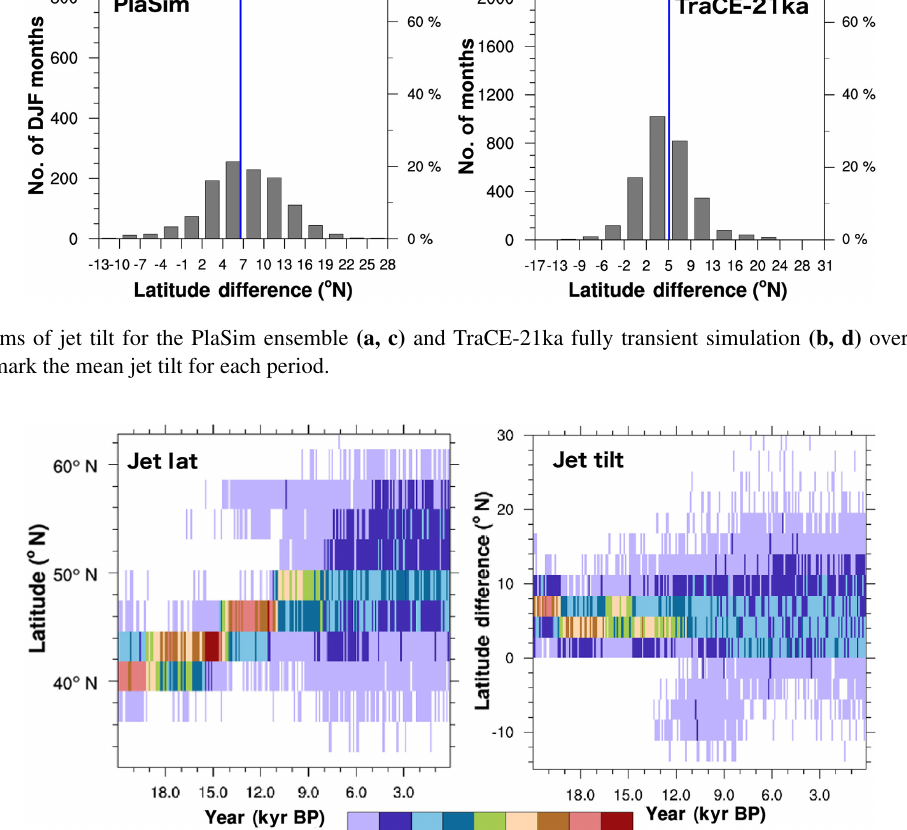
and does not change over the deglaciation (Fig. S7),